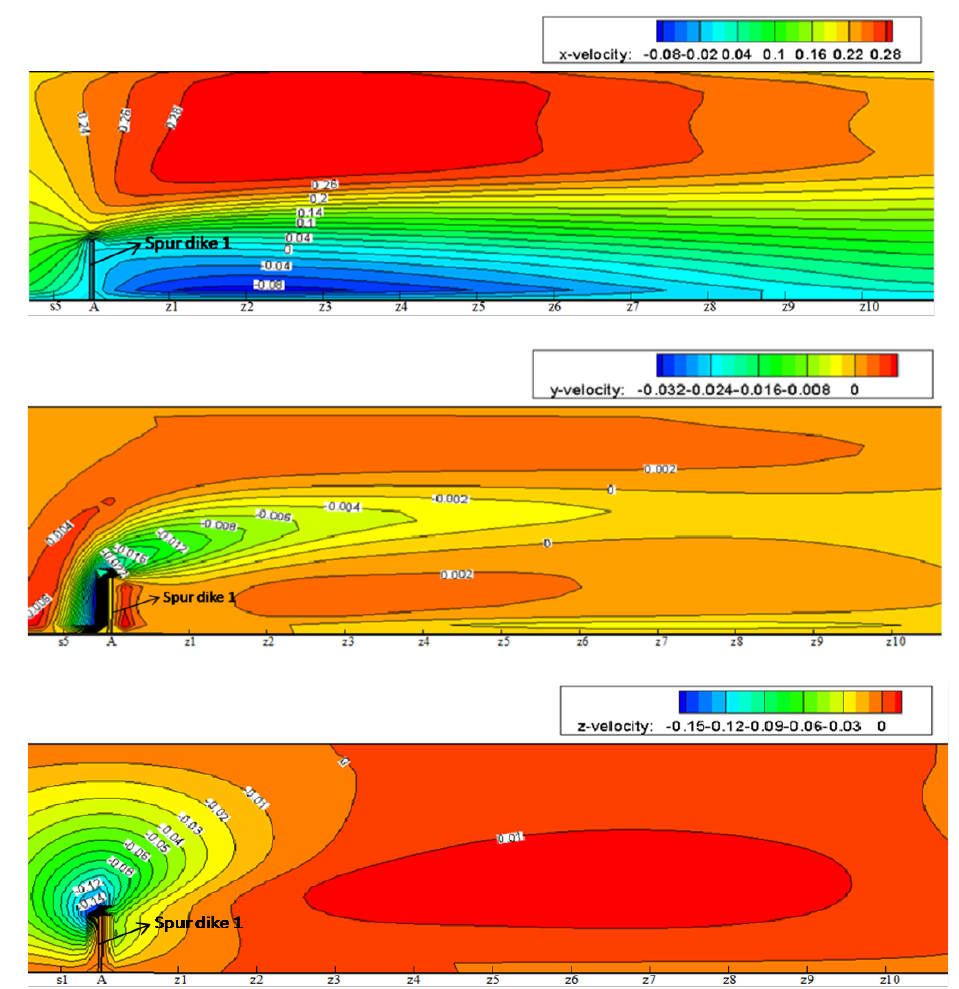
Figure 5. The flow structure near spur dike 1: ( a ) surface image in initial stage of visualization, ( b ) surface image in last stage of visualization, ( c ) numerical result on the horizontal plane of Y = 0.08 m, and ( d ) experimental result on the horizontal plane of Y = 0.08 m.